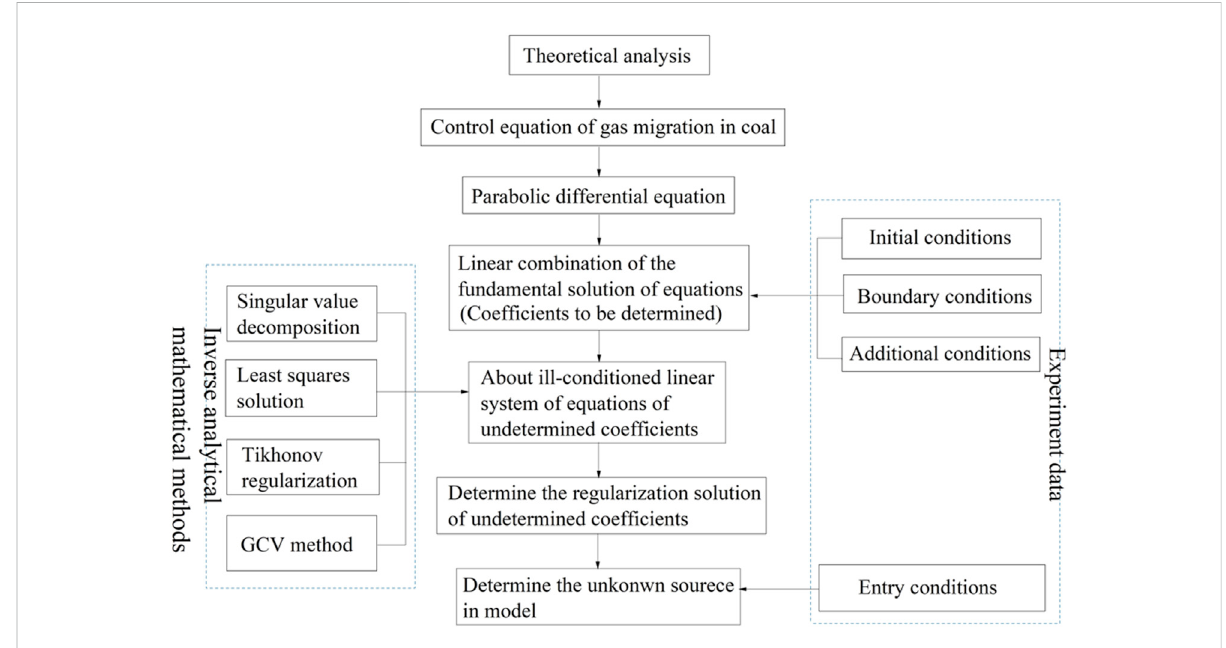
FIGURE 2 Identi fi cation process of the unknown source functions in the mutual model.